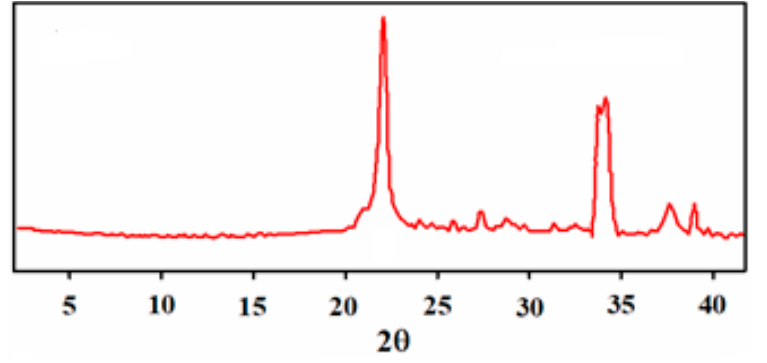
Figure 4. XRD pattern of the zeolite.